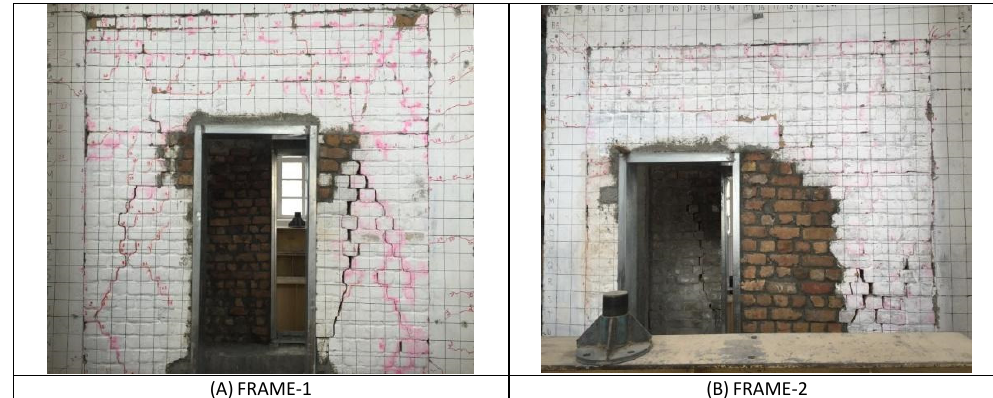
FIG. 3. REPAIRING OF DAMAGED INFILL WALL AND STEEL DOOR FRAMES INSTALLED